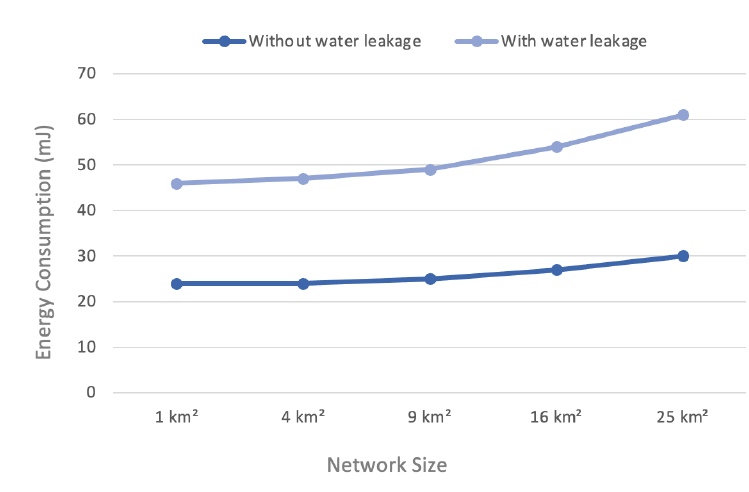
Figure 6. Energy consumption versus network